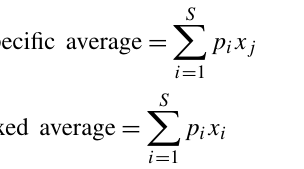
3 subalpine sites, encompassing 19.8 ◦ in latitude (32.6– 52.4 ◦ N) and 46.1 ◦ in longitude (86.7–132.8 ◦ E) in